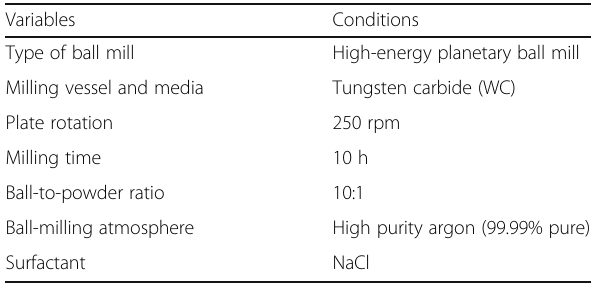
Table 1 Ball-milling conditions employed for